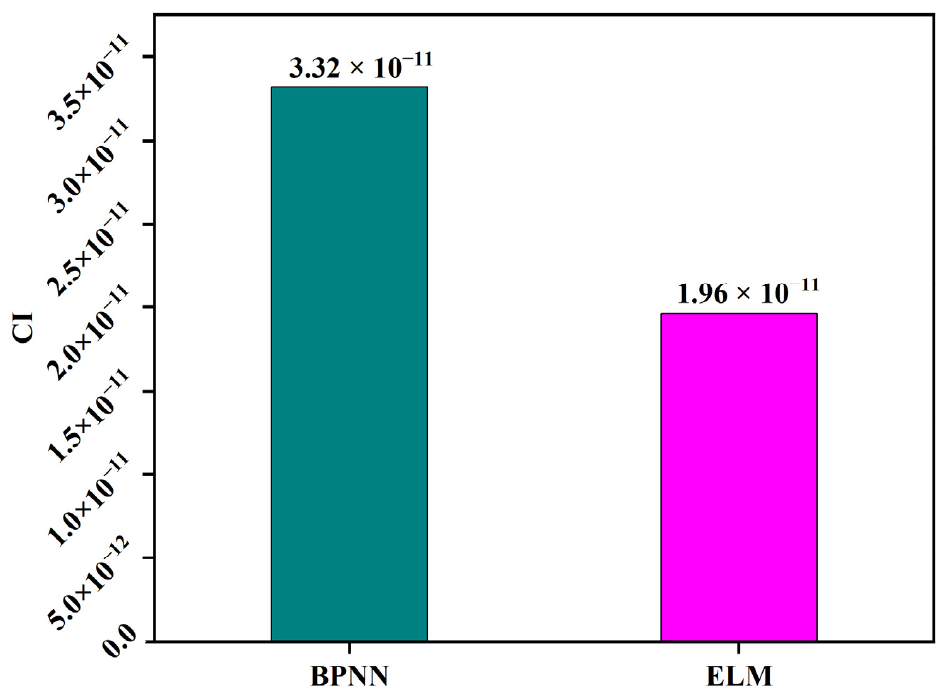
Figure 14. The CI values of the developed BPNN and ELM models.